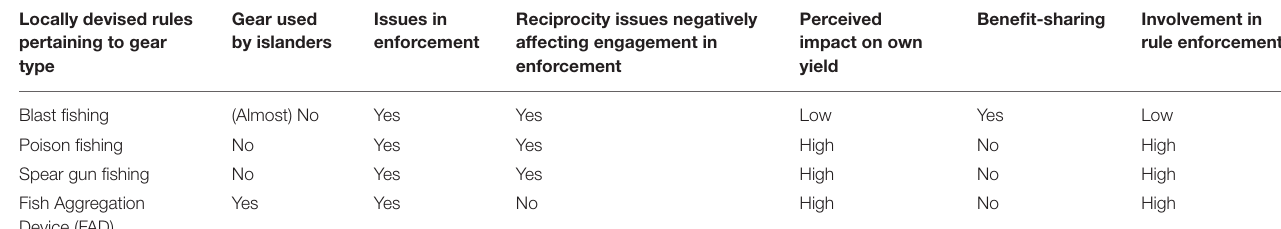
TABLE 2 | Summary of the Fishers’ rationales for engaging in the enforcement of the local rules. Locally devised rules pertaining to